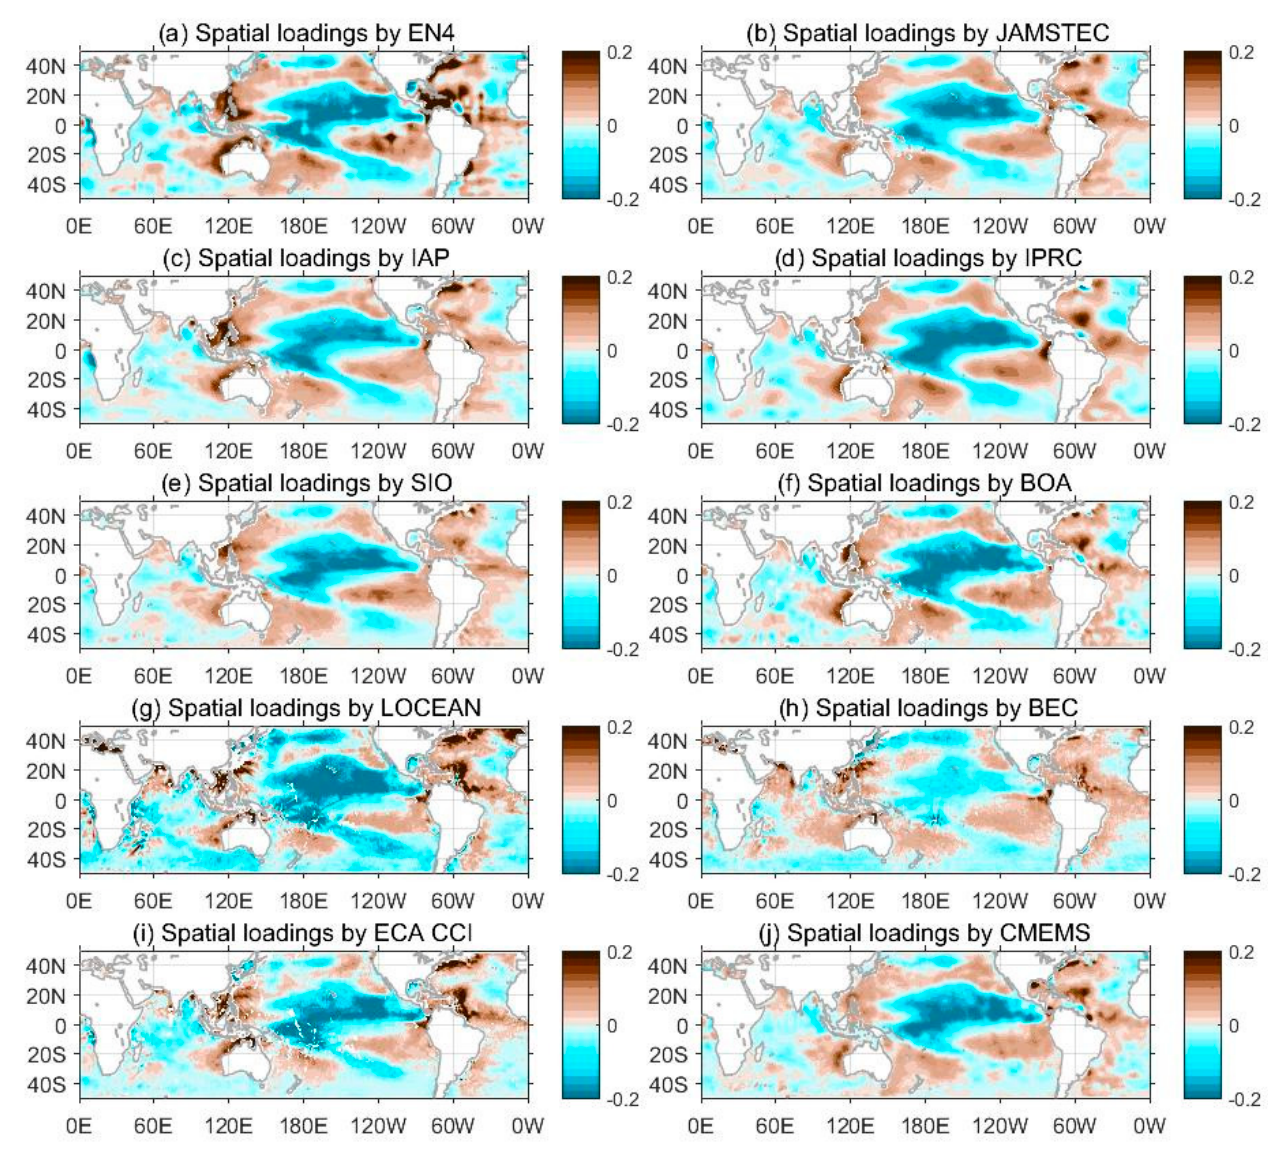
Figure A3. The spatial pattern of the leading mode of the interannual SSS variations from ten products. The units are in g/kg.